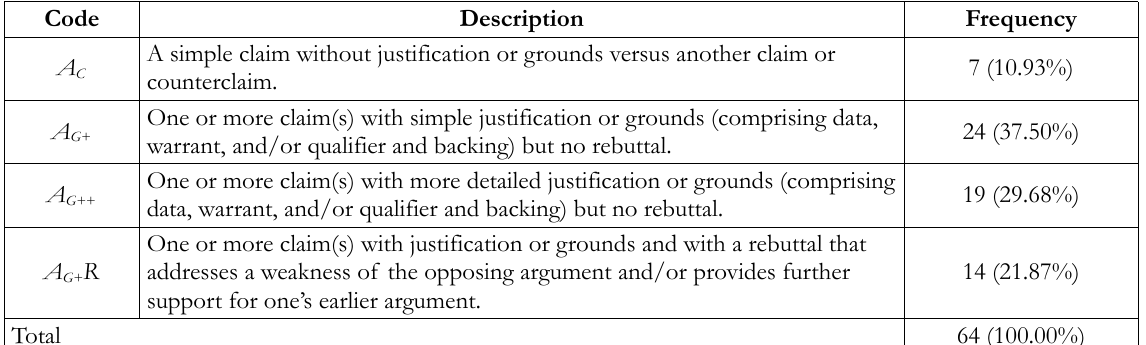
Table 5. Students’ scientific argumentation in the Need for knowledge